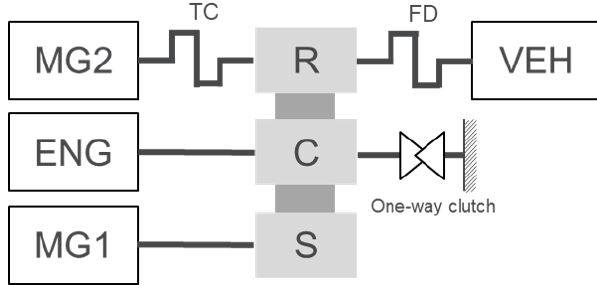
Figure 1. Schematics of the powertrain. Table 1. Vehicle model